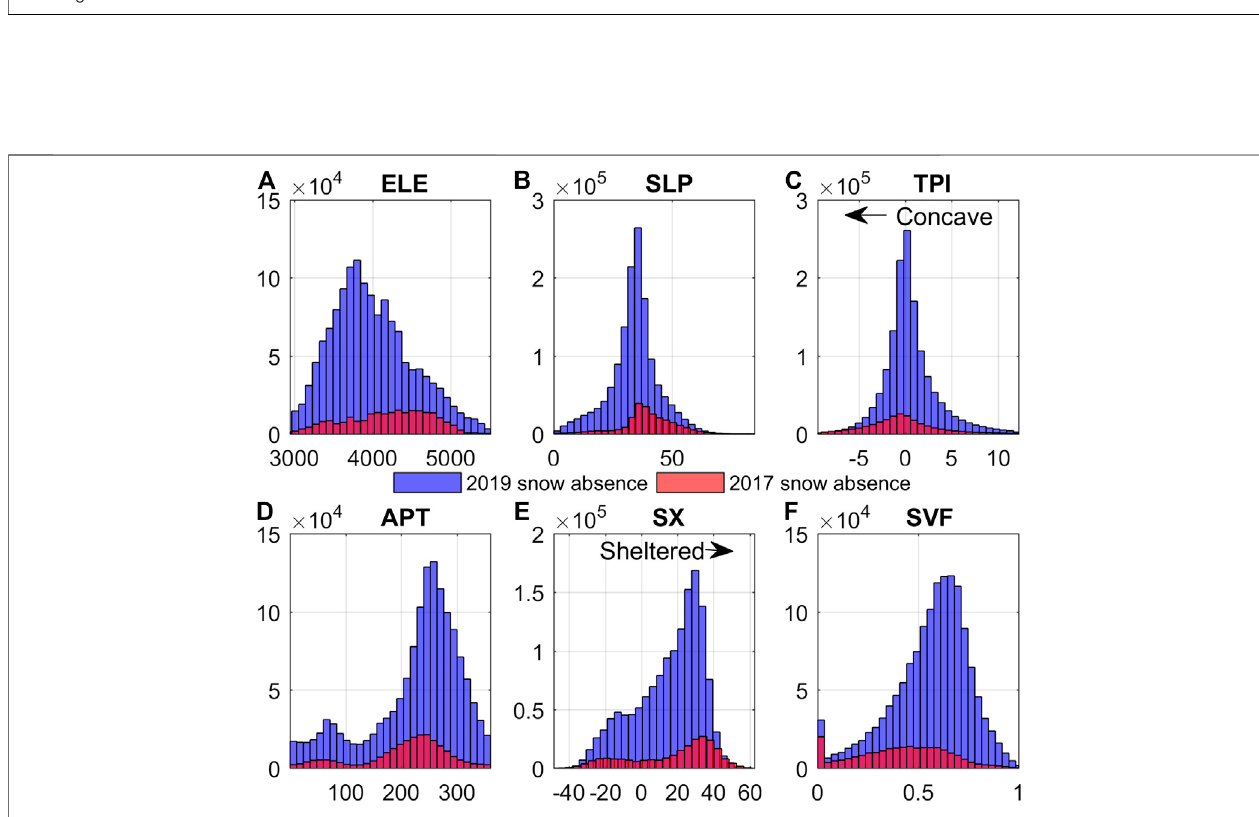
FIGURE11| Histogramsofsnowabsencein1 yearonly(2019inblueand2017inred)whengroupedagainstthetopographicalindices.ArrowsforTPIandSXare used to clarify the meaning of positive and negative values for those indices.